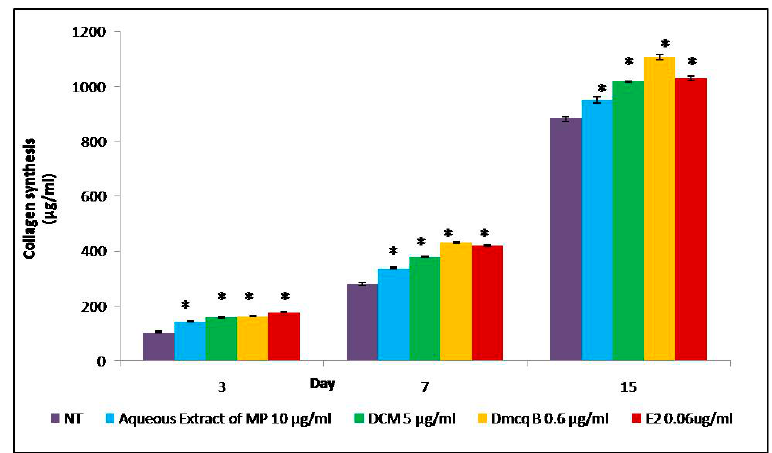
Figure 5. Collagen content from Sirius Red staining was measured at 15 days of differentiation induction. All M. pumilum var. alata treatments have significantly increased collagen content compared to non-treated group with ascending pattern, resembling the effects of E2 treatment. The data are presented as means of percentage of treatment ± SEM; n = 6. * Significantly increased ( p < 0.05) compared to NT group at corresponding day of differentiation. NT non-treated group MP M. pumilum